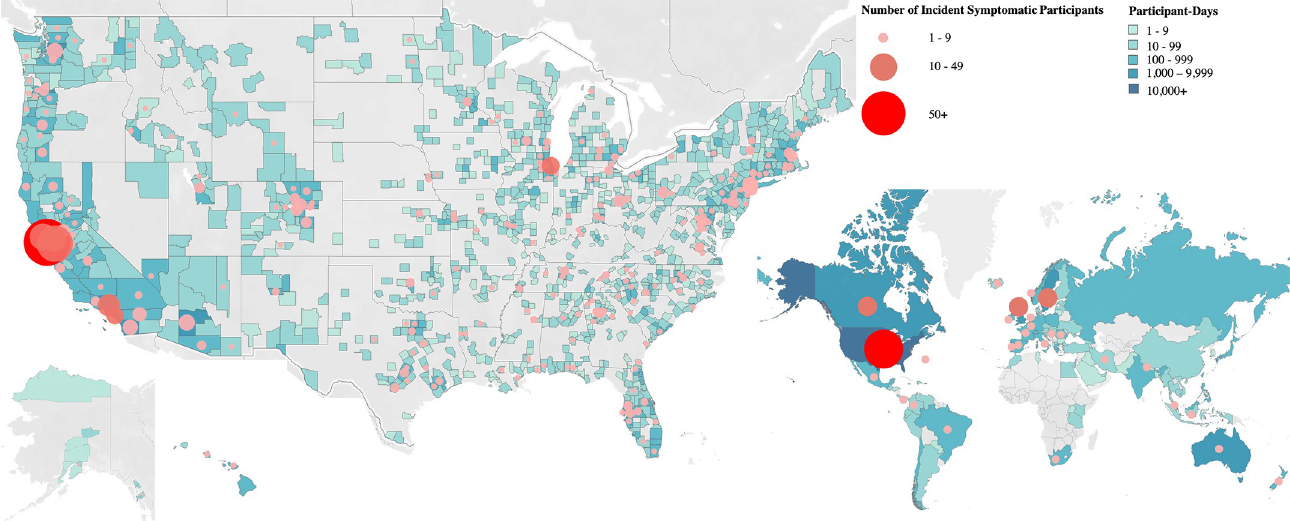
Fig 1. Location of study participants. Blue shading represents gradations of the number of participant-days within the US by county (left) and in the world by nation (right). Red shading depicts the number of symptomatic participants by location. Created with software provided by Tableau (www.tableau.com; San Francisco, CA) and published with their permission under the Creative Commons Attribution License (CC BY 4.0).